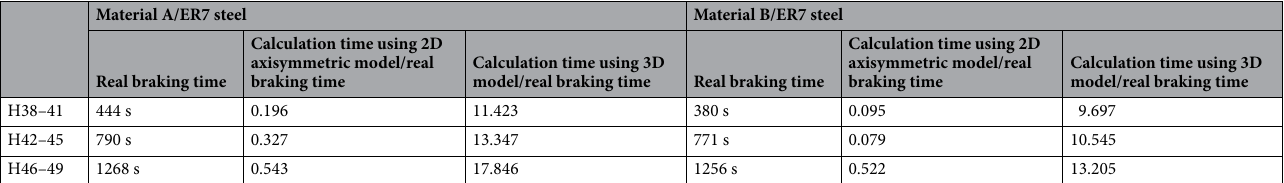
Table 12. Braking times and computation times obtained for 2D axisymmetric and 3D